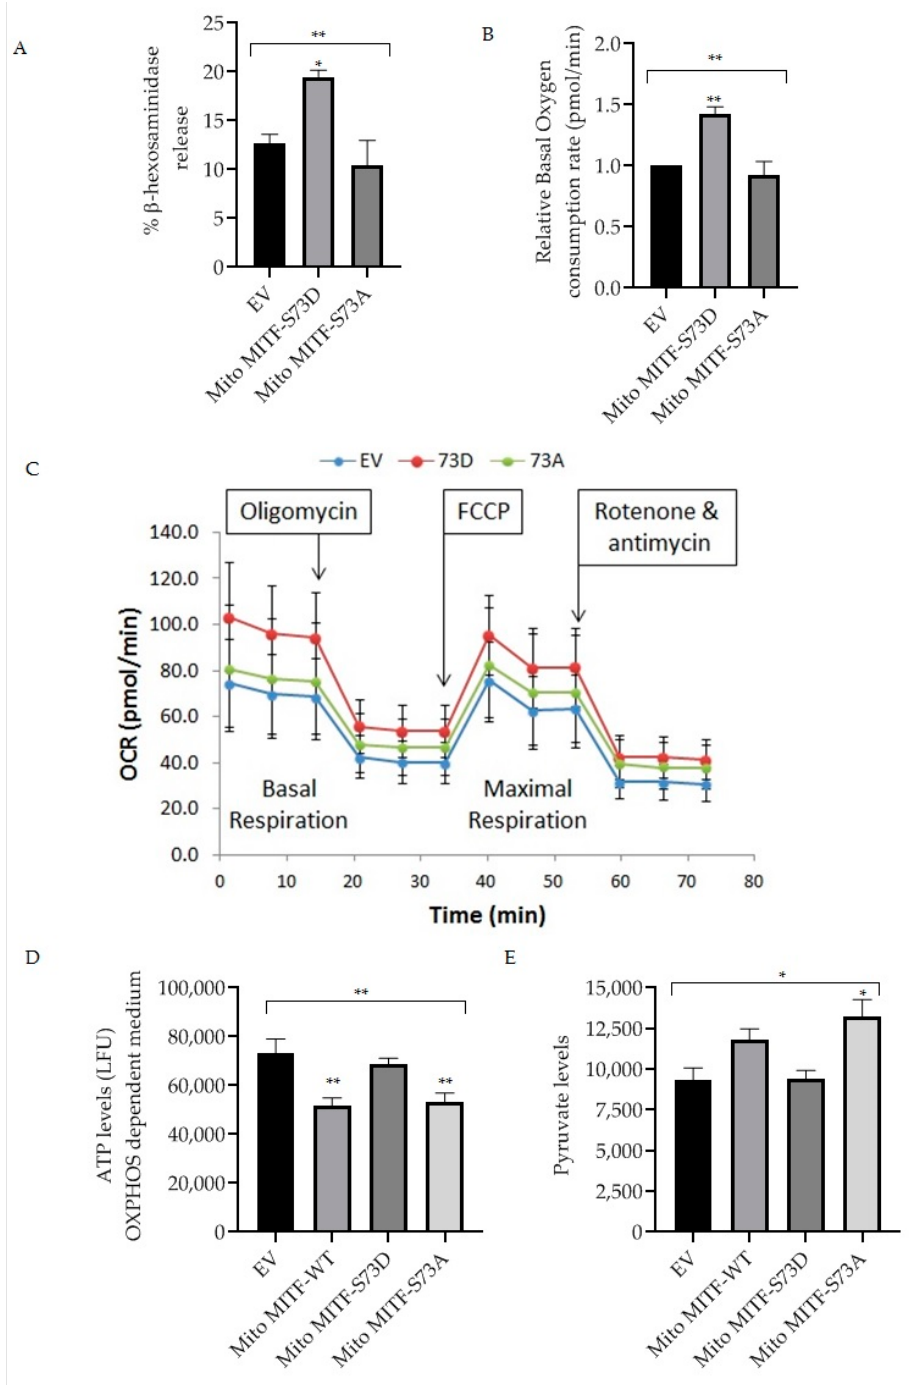
Figure 5. Effect of overexpression of mitochondrial MITF Serine 73 mutants ( D or A ) on mast cell degranulation and mitochondrial functions. Transfections were made in RBL cells either with EV or mitochondrial MITF-S73D or mitochondrial MITF-S73A. After 48 h, cells were stimulated with IgE-DNP and degranulation activity was assessed by measuring β -hexosaminidase release ( A ). Relative oxygen consumption rate at basal respiration was compared in transfected RBL cells ( B ). One (out of 3 experimental repeats from Figure 5B) of the Seahorse XF cell Mito Stress profile is shown to assess the effect of mitochondrial MITF-S73D or S73A on mitochondrial respiration, where each dot represents means ± SDs (n = 12) ( C ). Mitochondrial ATP ( D ) and pyruvate levels ( E ) 48 h after transfection were measured and compared with mitochondrial MITF-WT. Results represent means ± SEMs (n = 3 or 4, ** p ≤ 0.01; * p ≤ 0.05; ns p >